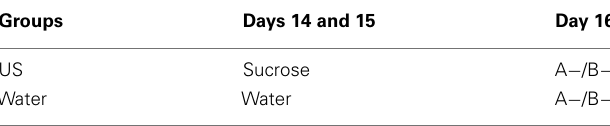
Table 2 | Design table of US postexposure treatment and